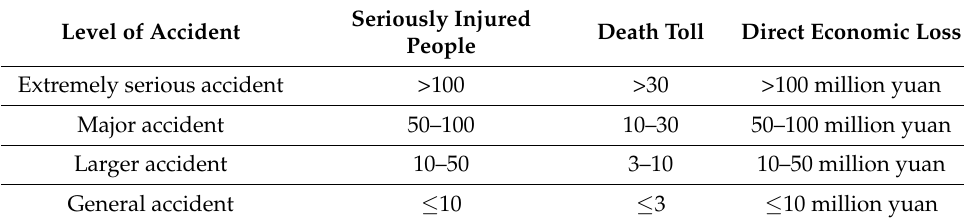
Table 6. Grading of the severity of consequences of the Regulations on the Reporting and Investigation of Production Safety Accidents.